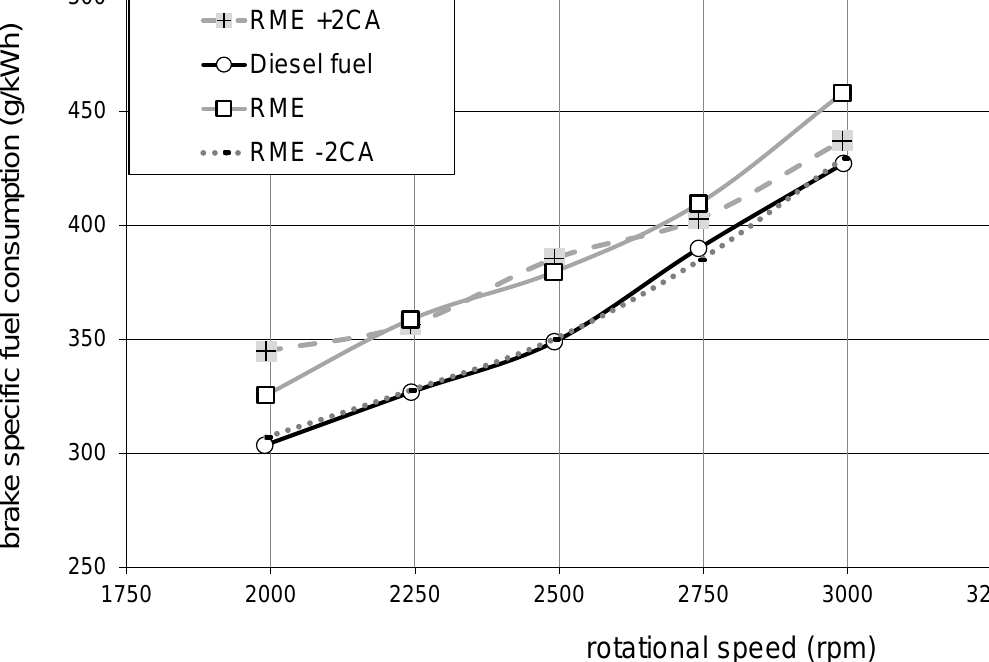
Figure 20. Torque as a function of the rotational speed at full load, for different values of the SOI and for the two tested fuels.